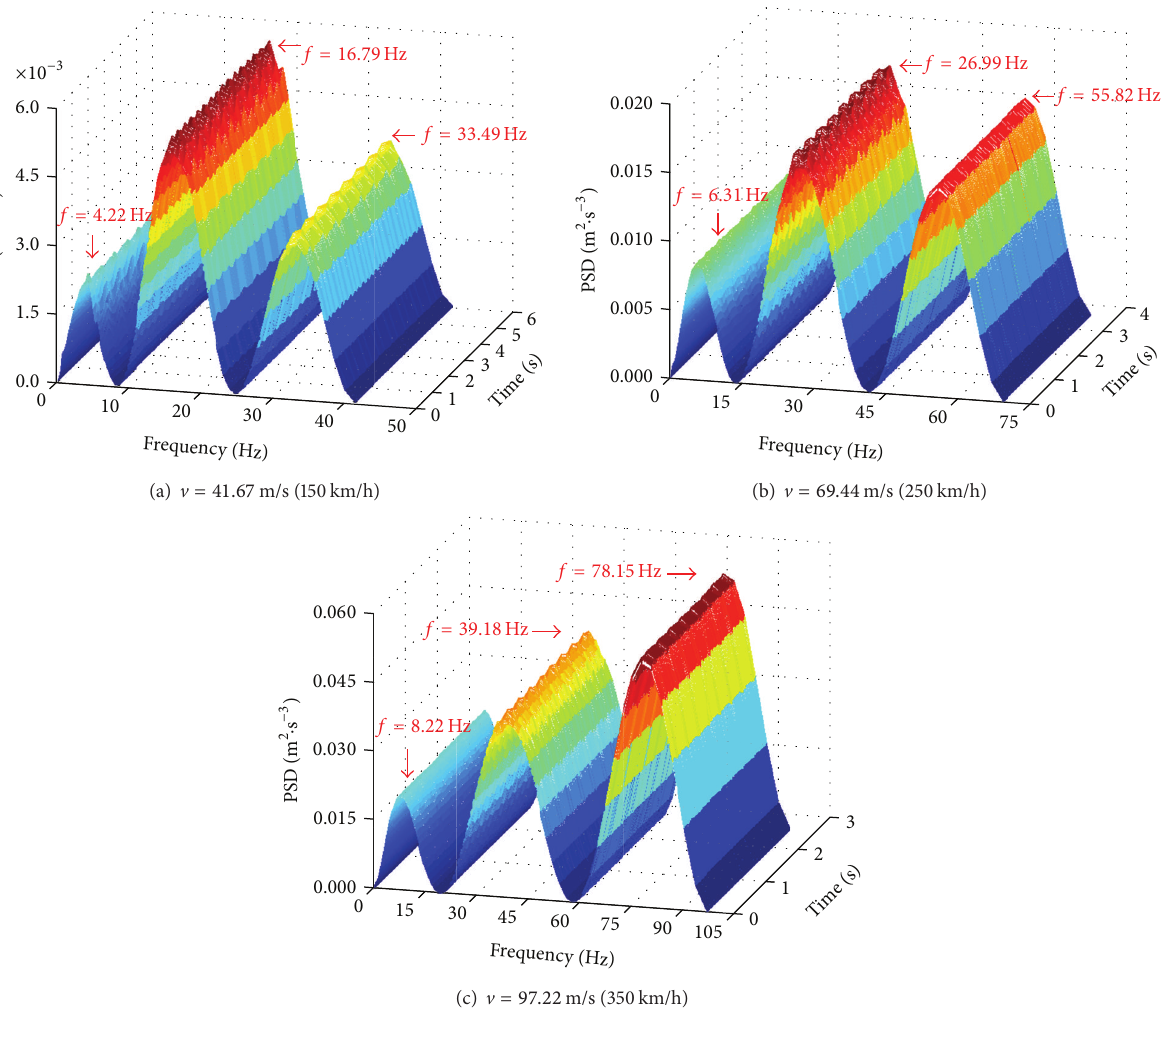
Figure 24: PSD of vertical acceleration of trailer car rear